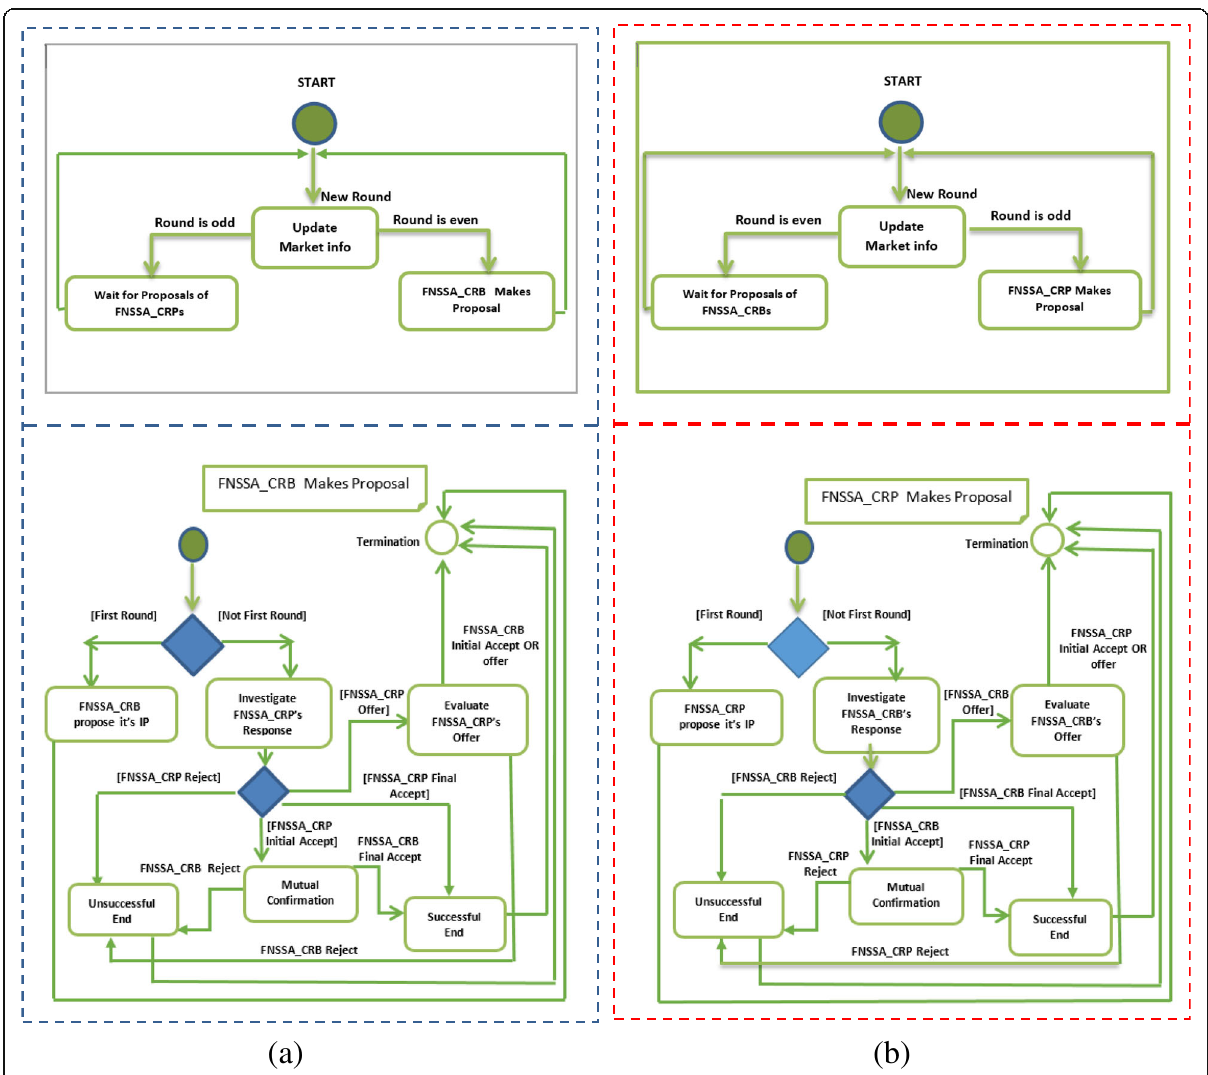
Fig. 3 a State diagram of the negotiator agents of type CRB in the market environment, b State diagram of the negotiator agents of type CRP in the market